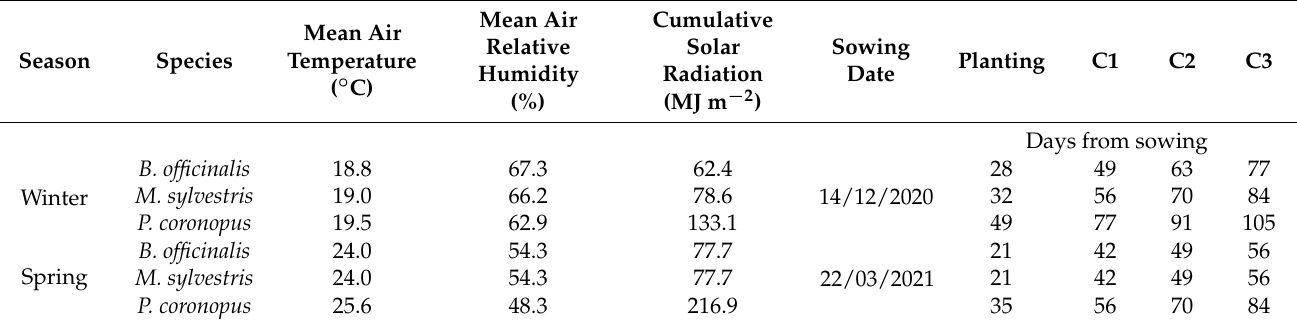
Table 1. Environmental conditions during the experiment with Borago officinalis, Malva sylvestris and Plantago coronopus hydroponically grown under greenhouse in winter or in spring and subjected to three consecutive cuts (C1, C2, C3). The dates of sowing, transplantation and cuts are also